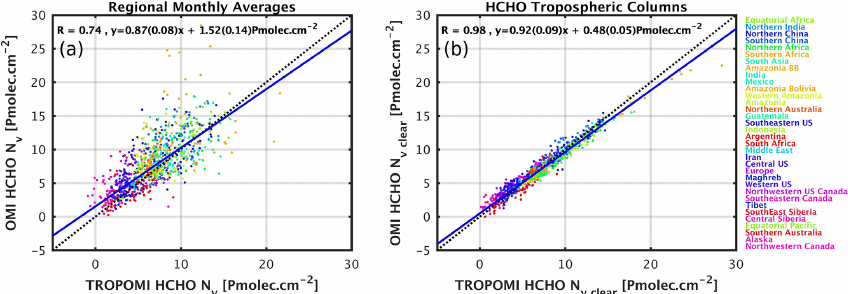
Figure 8. Scatter plots of OMI versus TROPOMI columns for the monthly means of collocated data. Results are shown for N v (a) and N v_clear (b) . The correlation, slope and intercept of a linear regression using the robust Theil–Sen estimator are given in each panel and plotted as a blue line. The black dotted line is the 1:1 line. The colour indicates the latitude of the region. (Pmolec.cm − 2 = 1 × 10 15 molec.cm − 2